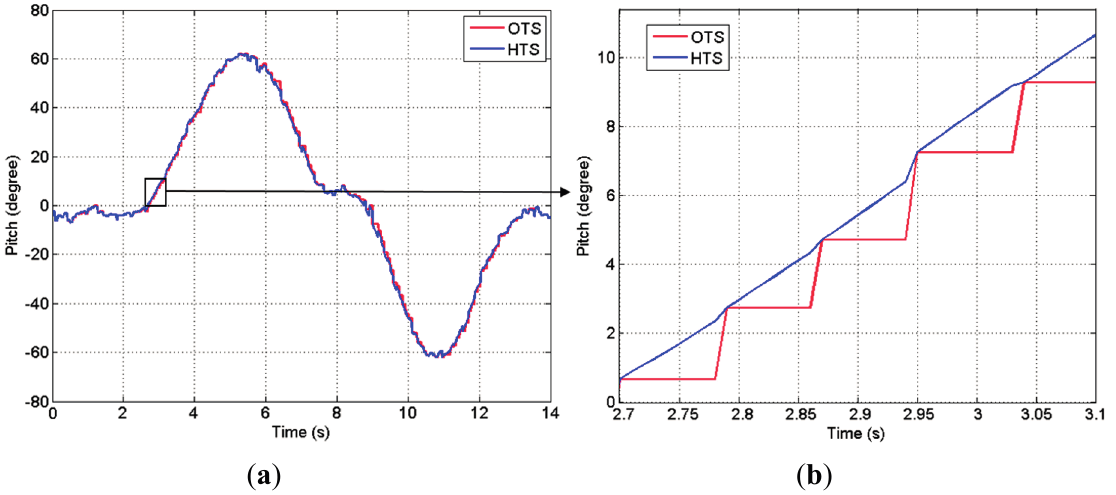
Figure 2. ( a ) Orientation tracking results of the hybrid tracking system (HTS), which has a higher update rate than the optical tracking system (OTS); ( b ) Orientation tracking results in period of 2.7 s–3.1 s. Red: The OTS result at an update rate of 20 Hz. Blue: The synchronized tracking result based on the OTS result and updated by inertial measurement unit (IMU) measurement between two samples of